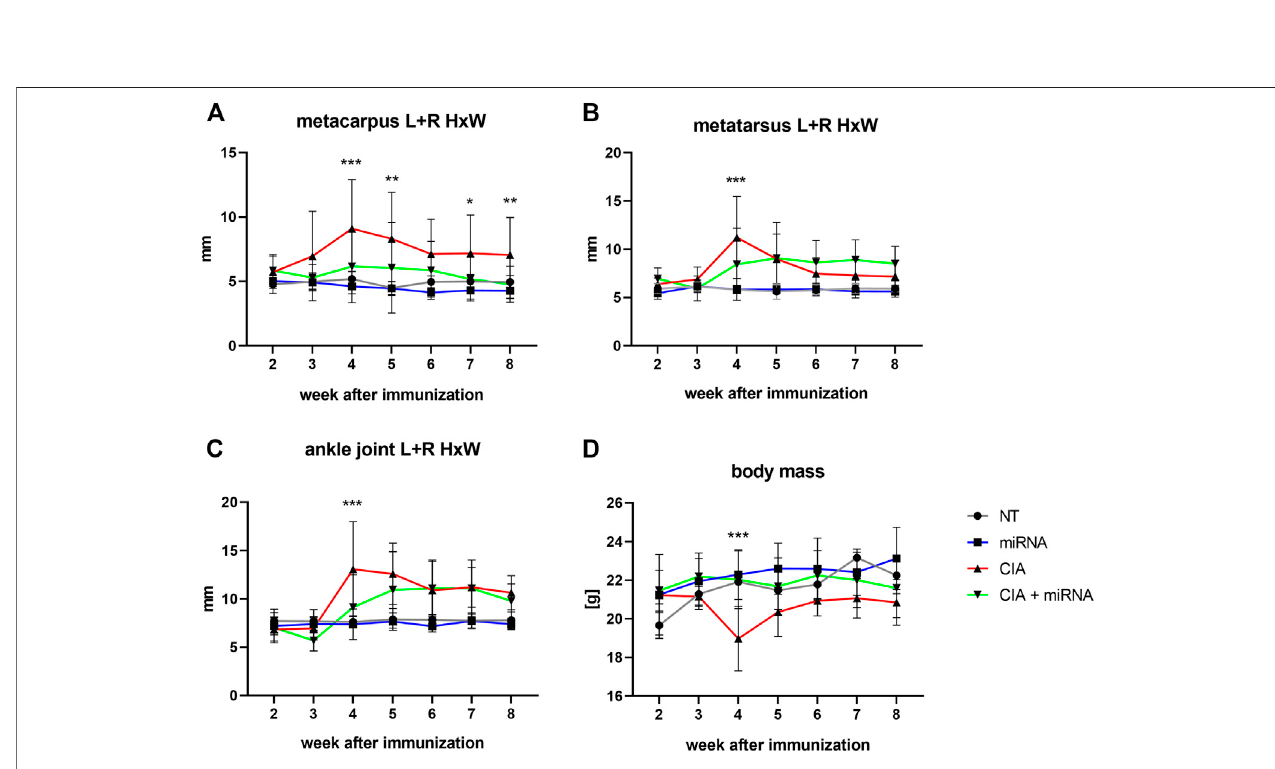
FIGURE 4 | The ratio of width and height of the metacarpus (A) , metatarsus (B) , and ankle joint (C) and mean body mass (D) of experimental animals in the following weeks of the experiment. Statistical signi fi cance for CIA vs. CIA + miRNA marked on the graph. For statistical signi fi cance between other groups, see Supplementary Material ( Supplementary Table S1 ). The statistical signi fi cance is marked in the fi gure as follows: * p < 0.05; ** < 0.01; *** p < 0.001. n = 4 (NT, miRNA, CIA), n = 8 (CIA + miRNA).